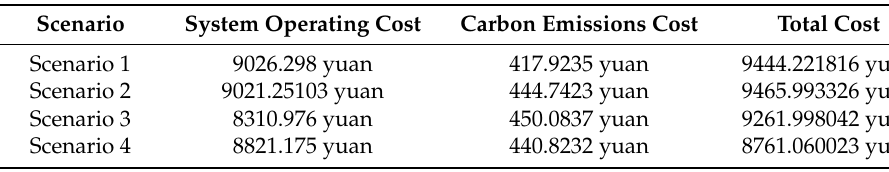
Figure 6. The output structure of each device in Scenario 4. Table 4. The cost of the system in different scenarios. Table 4. The cost of the system in different scenarios.